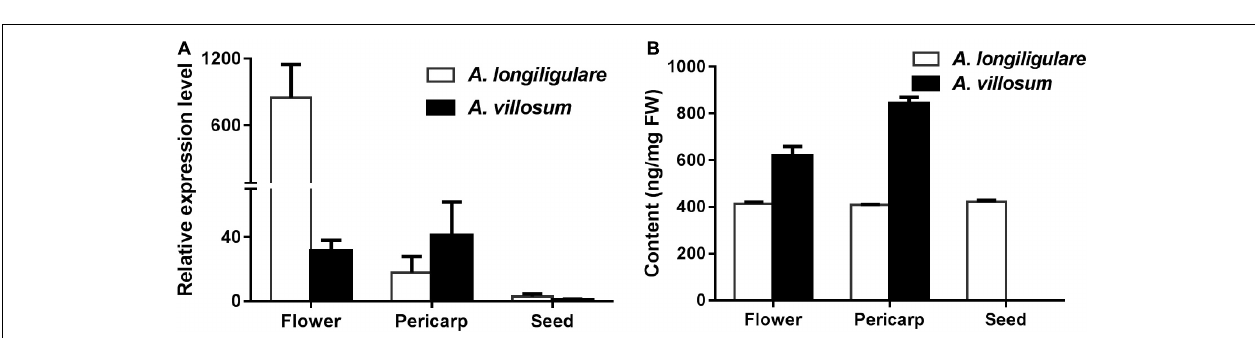
FIGURE 3 | Analysis of reaction products generated by recombinant protein AlTPS2 and AvTPS2 from GPP. (A) The GC-MS chromatogram of the monoterpenoid products generated by AlTPS2 and AvTPS2 protein and the linalool standard. (B) Mass spectra of peak 1 in the NIST17 library compared with the mass spectra of the linalool standard.